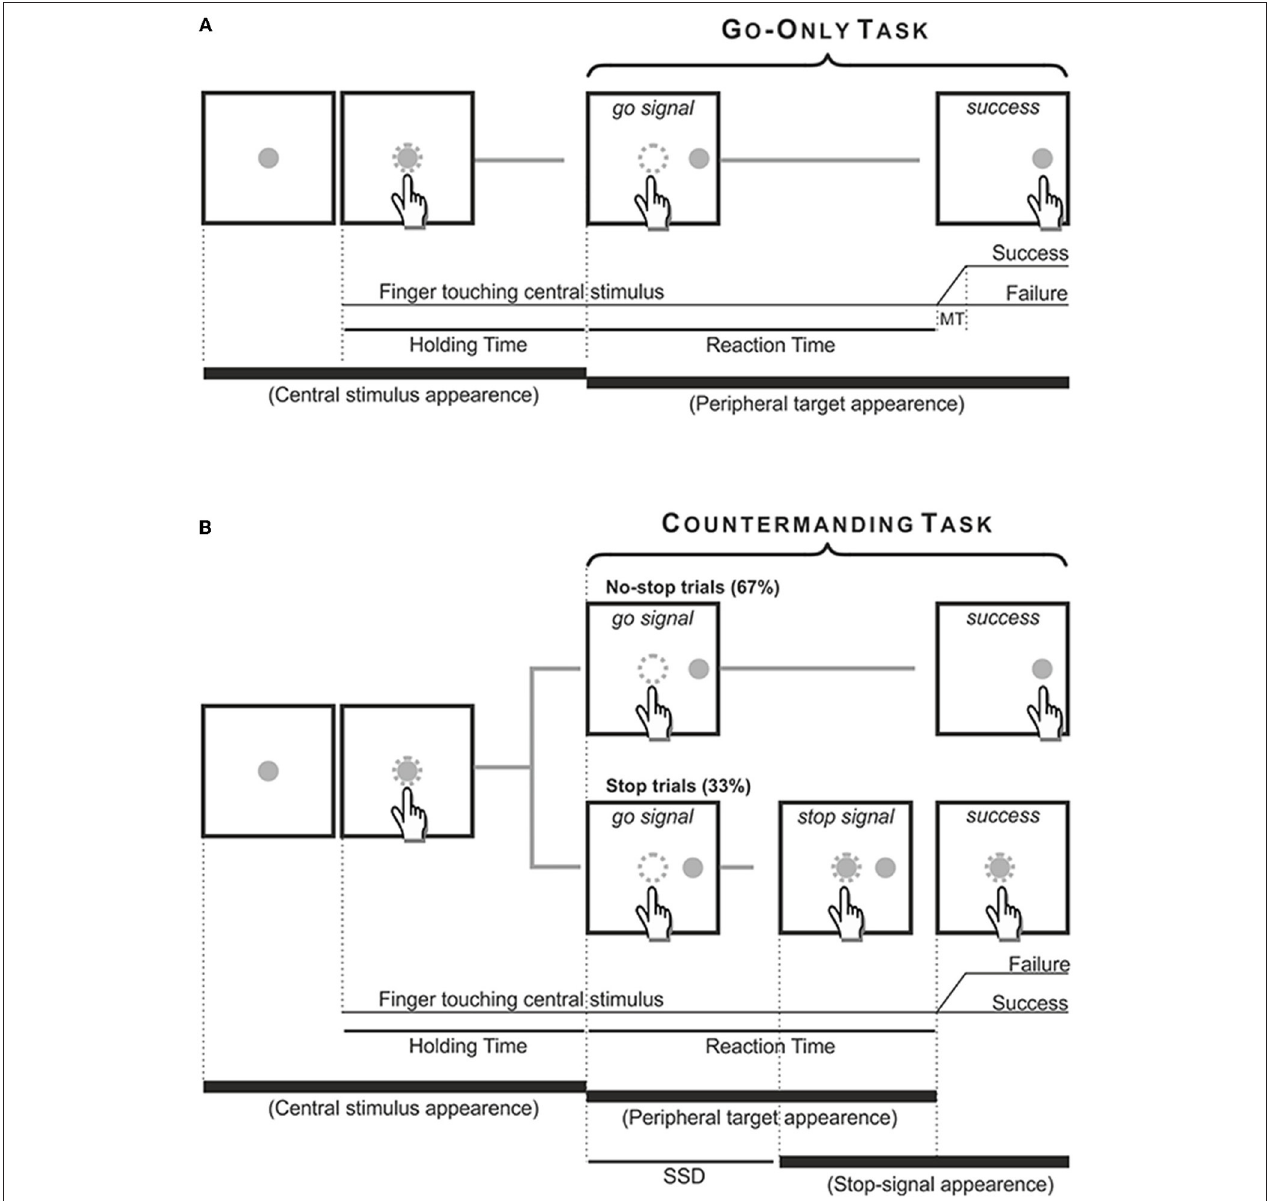
FIGURE 2 | Temporal sequence of the visual displays for go-only, no-stop (A) and stop trials (B) . All trials began with the appearance of a central stimulus. The subject had to reach and hold it with the index of the right arm for 500–800ms. (A) In the go-only task and in the no-stop trials of the countermanding task the central stimulus disappeared and, simultaneously, a target appeared 13.5cm or 18.6 dva to the right, acting as a go-signal. Subjects were instructed to perform a speeded reaching movement toward the peripheral target and to hold it for 300–400ms. Randomly, in 33% of trials of the countermanding task [stop trials, (B) ] the central stimulus (stop-signal) reappeared at a variable delay after the go signal (stop signal delay, SSD), indicating that the subject should cancel the pending movement. In these stop trials, if subjects countermanded the planned movement keeping the arm on the central stimulus for a period of 400–600ms, the trial was scored as a stop-success trial. Otherwise, if subjects executed the reaching movement the trial was scored as a stop-failure trial. The dotted circle (which was not visible to the subjects) indicates the size of the tolerance window for the touches (3.5cm or 5 dva of diameter).